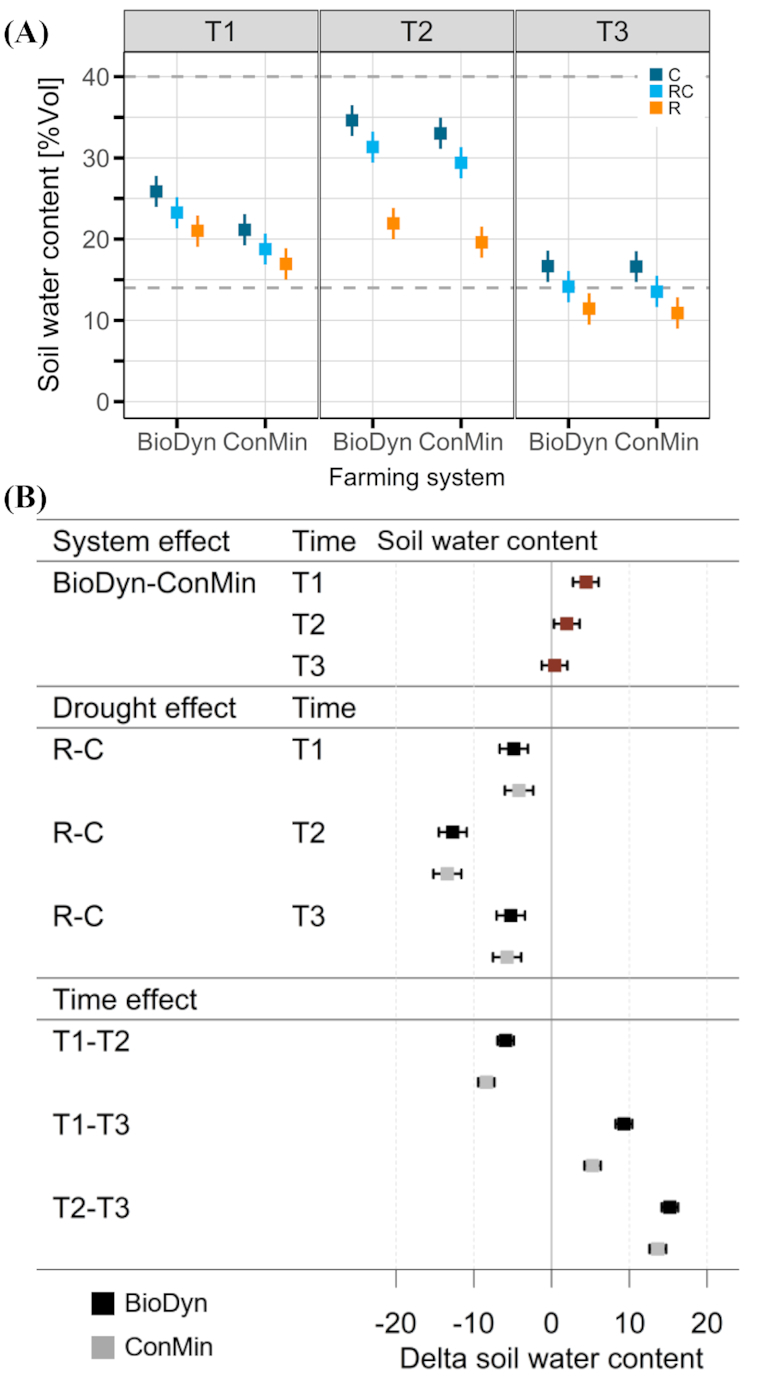

(A) Volumetric soil water content; dashed lines: estimated wilting point (bottom), field capacity (top); (B) differences in soil water content (in percentage points); system and time effect are given as averages over the drought treatments. All data are presented as medians of the posterior distribution with 95% credible intervals (CrIs). Factor system: biodynamic farming system (BioDyn), conventional farming system with pure mineral fertilisation (ConMin); factor drought: control (C, no shelter), rainout shelter control (RC), rainout shelter (R); factor time: 4 (T1), 8 (T2) and 13 (T3) weeks after rainout shelter set-up.